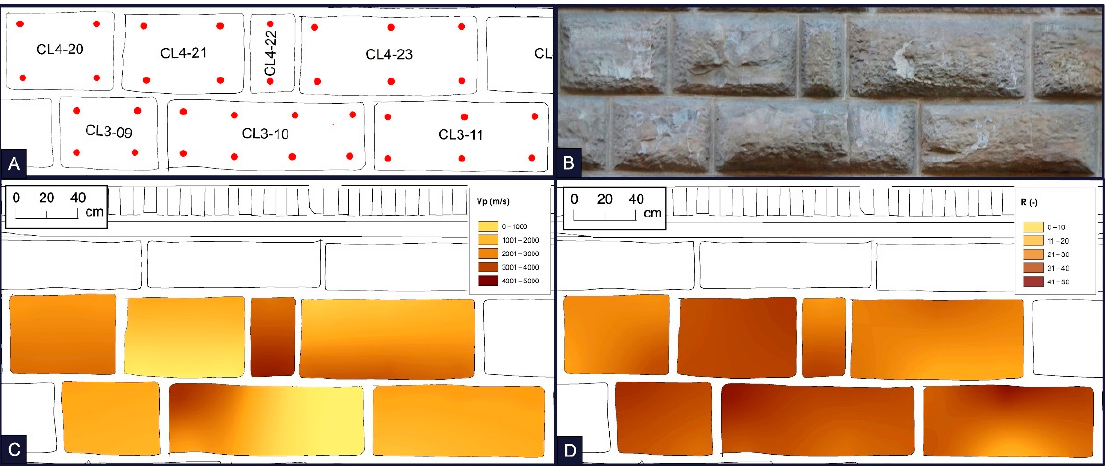
Figure 8. ( A ) Measurement scheme followed for NDT, outlined on a block portion; the red dots represent the grid of measuring points where the ultrasonic and sclerometric measurements were performed ( B ) portion of rough-hewn rustication investigated; distribution maps of ( C ) Vp values and ( D ) R values processed through GIS software.